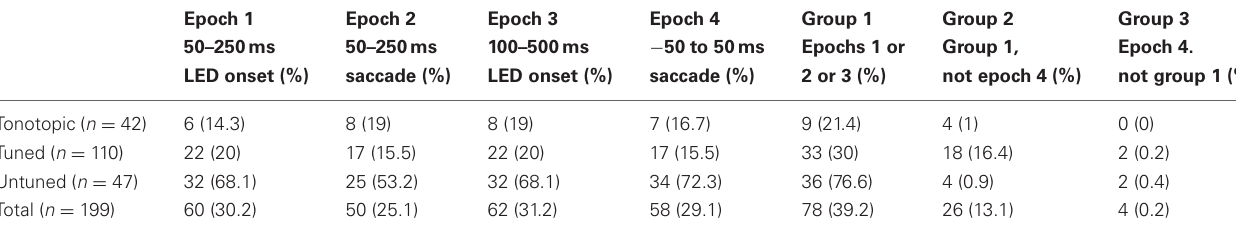
Table 2 | Proportion of visual/visuomotor sensitive sites in functionally defined locations by response